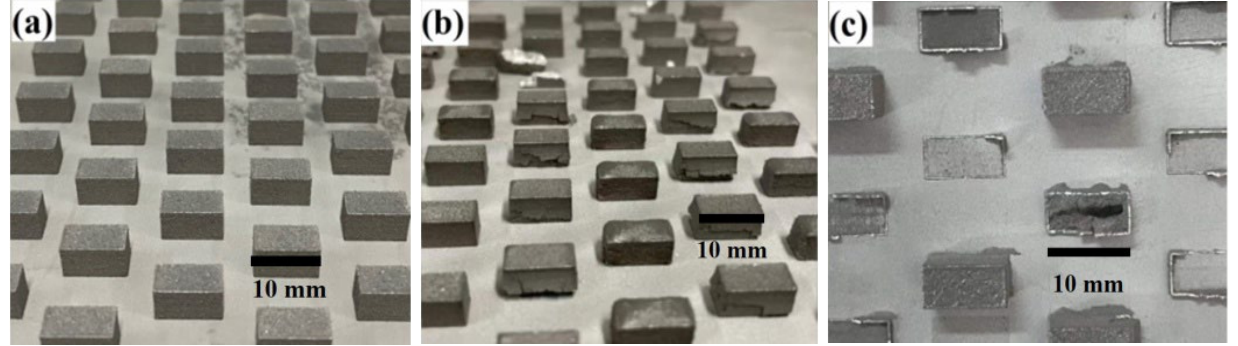
Figure 2. Photo image of 3D-printed Mg-based metallic glasses: ( a ) Samples in good condition (scanning speed: 1000 mm/s, and laser power: 100 W). ( b ) Samples with macrocracks (scanning speed: 900 mm/s, and laser power: 110 W). ( c ) Samples with unfused powders (scanning speed: 1200 mm/s, and laser power: 80 W).